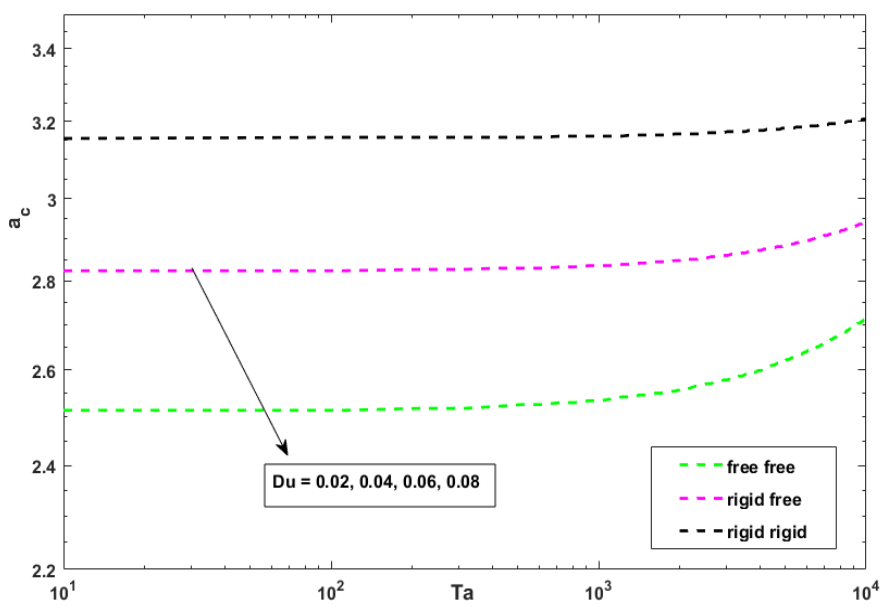
Figure 5. Variation of a c with Ta for Da = 0.01, Sr = 0.2, Rs = 200, Le = 5, Λ = 8, M = 0.9, ϕ = 0.9.